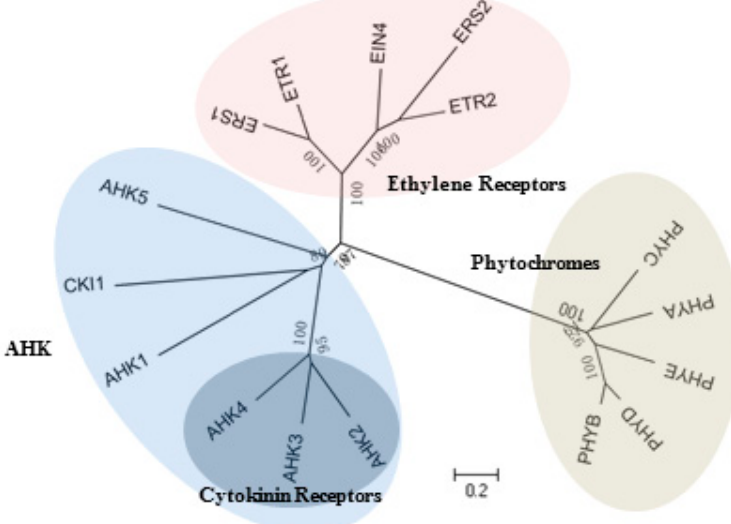
Figure 3. Phylogenetic relationship of HKs in Arabidopsis . The tree is branched into 3 groups: AHK family, ethylene receptor family and phytochrome family, 3 cytokinin receptors located in a subdivided branch of AHK family.